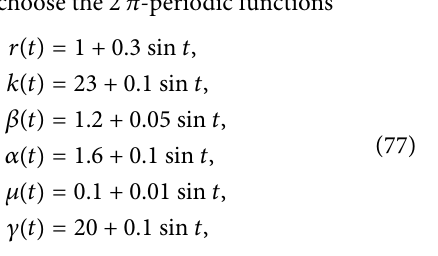
Figure 5: The solutions and phase diagram of the stochastic periodic system (3) with 𝜎 other parameters are taken as Eq.